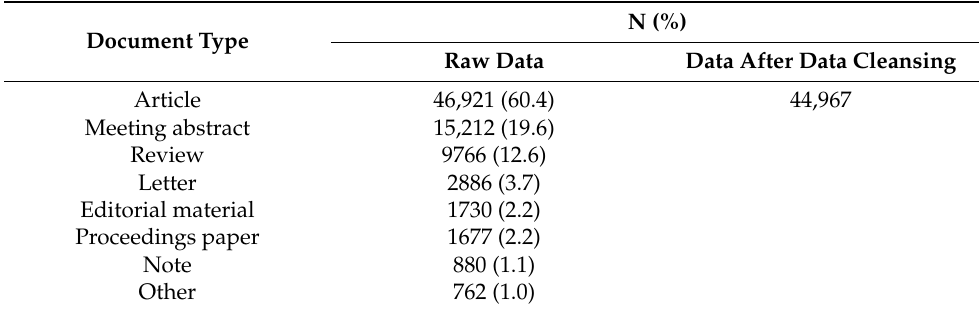
Table 1. Distribution of document types on systemic lupus erythematosus research published between 1971 and 2020 (N = 77,733).